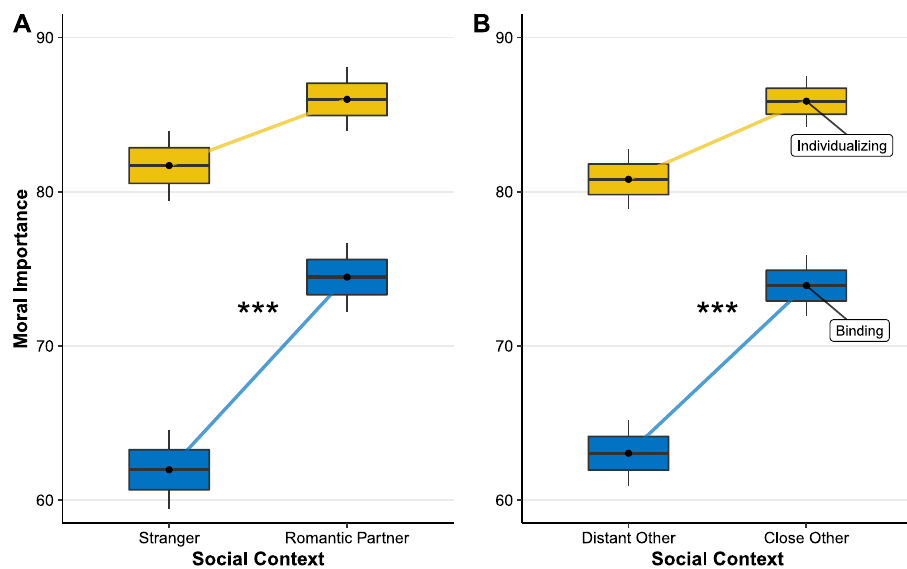
Fig. 4 The effect of imagining being in different social contexts and the importance afforded moral values. Each panel ( n = 580 and n = 752, respectively) shows the average rated importance of binding versus individualizing values when people are in the imagined presence of another person. A Participants imagined being in the presence of a romantic partner or a stranger (Study 4B); B participants imagined being in the presence of someone whom they do or do not “ feel close to ” (Study 4C). Box centers re fl ect group means; edges SEM; whiskers 95% CI. Source data are provided as a